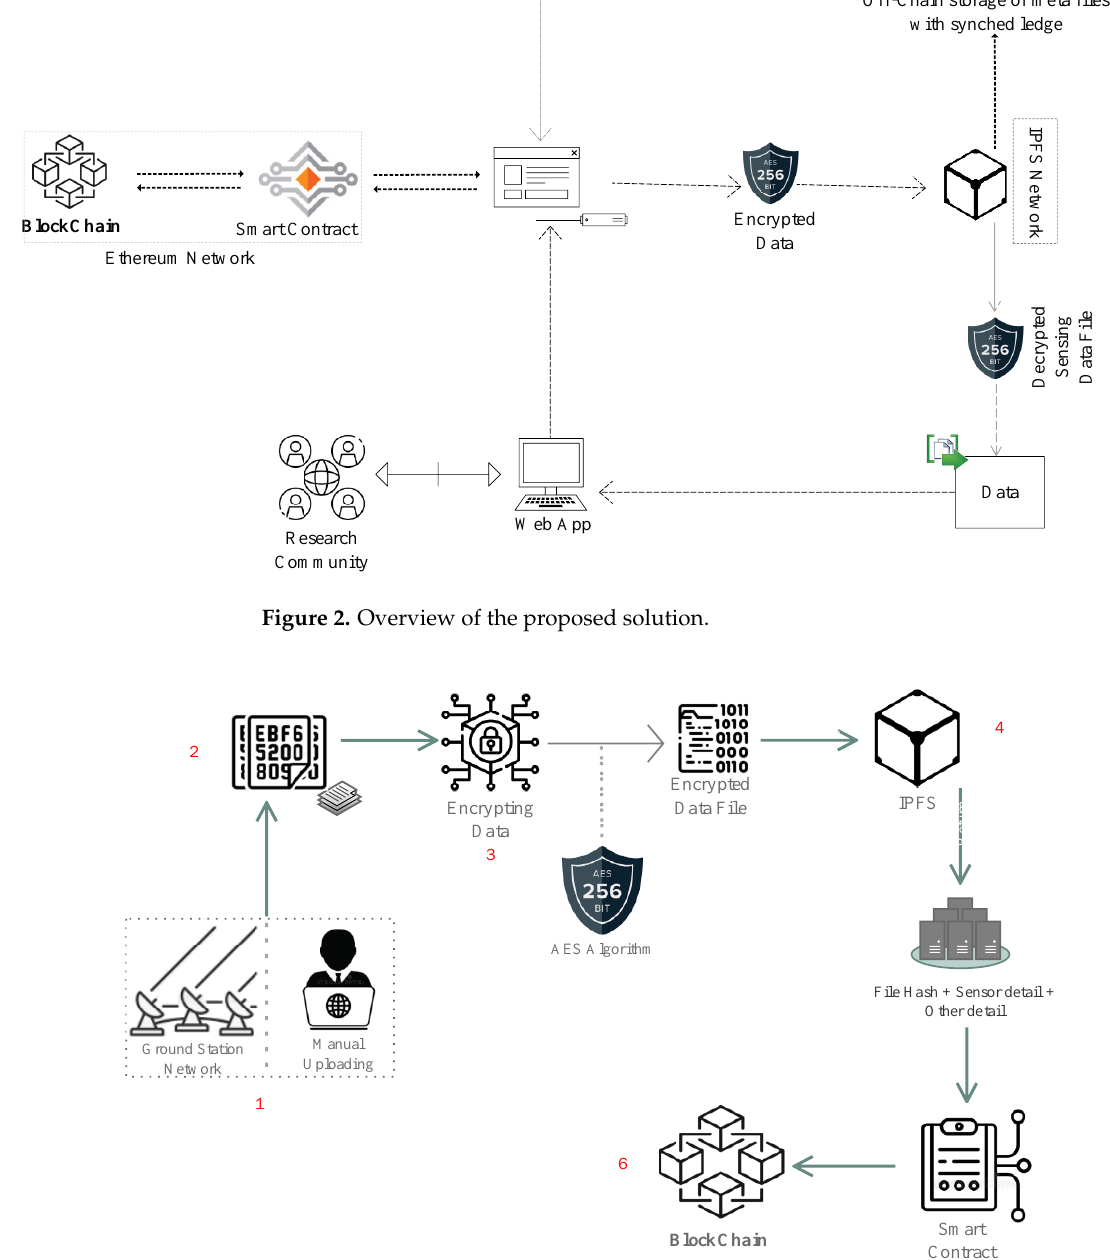
Figure 3. Methodology Data saving process.